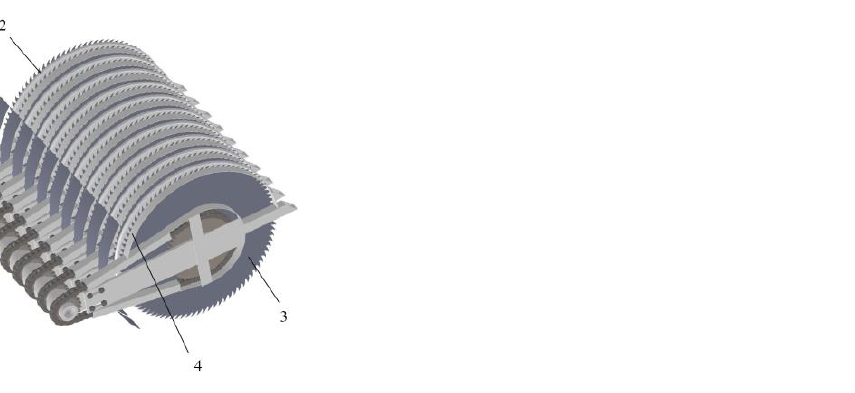
Figure 2. Sawtooth roll-tie-type cotton-picking mechanism: 1. straw shield; 2. ground wheel; 3. serrated disc; 4. guard ring.